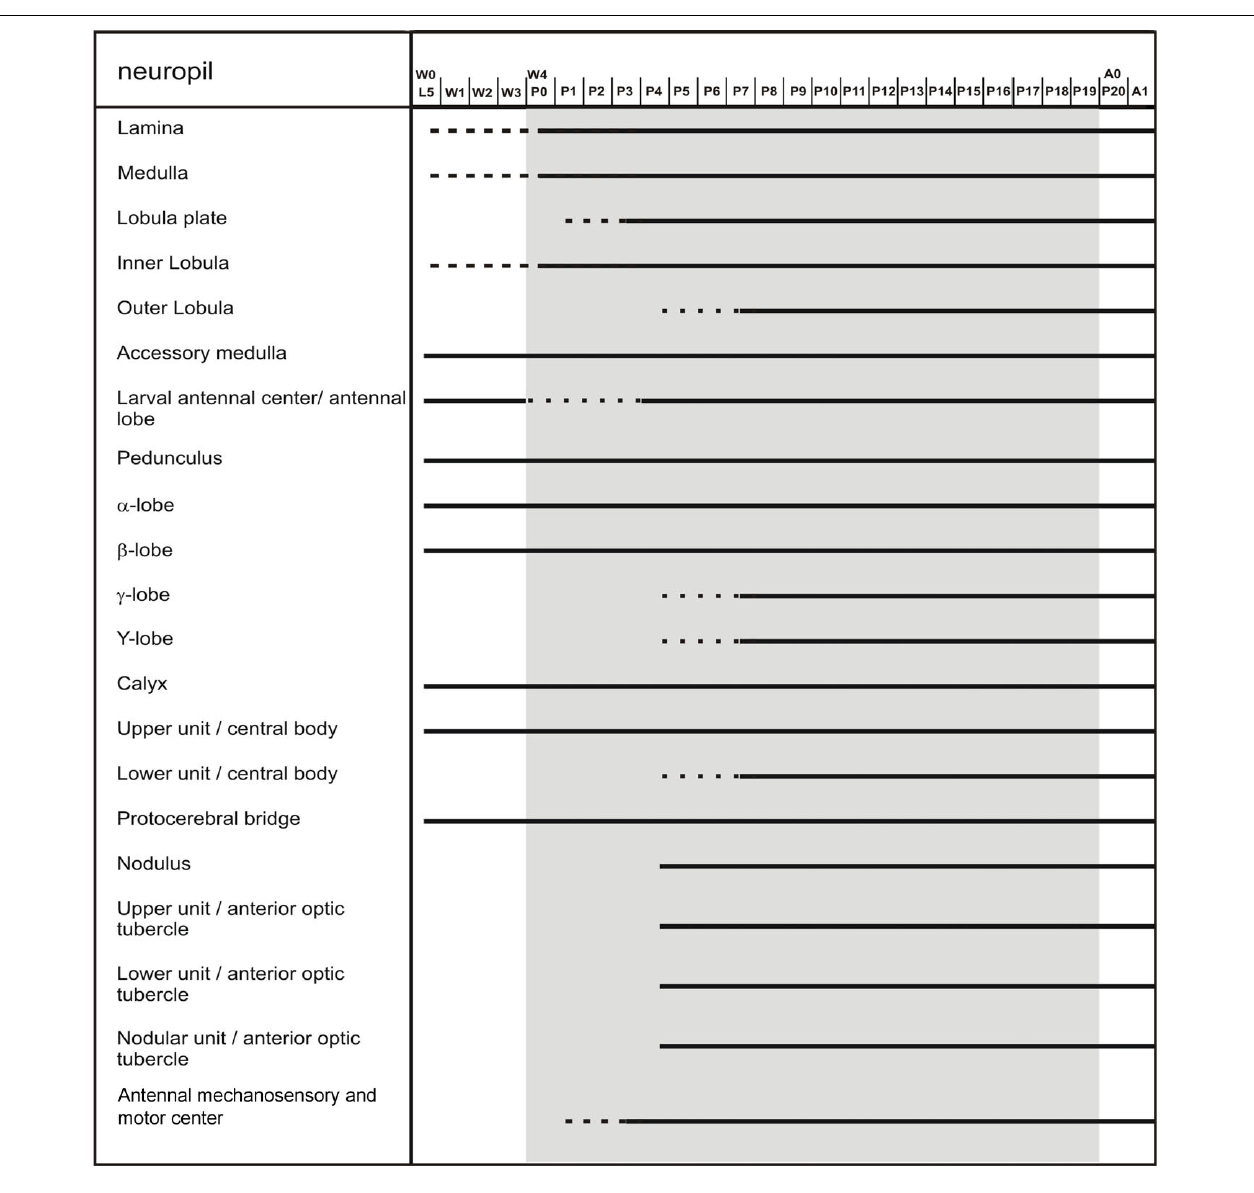
FIGURE 8 | Scheme of brain neuropil development. The scheme, based on anti-synapsin immunostaining, refl ects the developmental time course of the individual neuropils. Dotted lines represent the gradual appearance of a neuropil, or, in case of the larval antennal center, its transition into the antennal